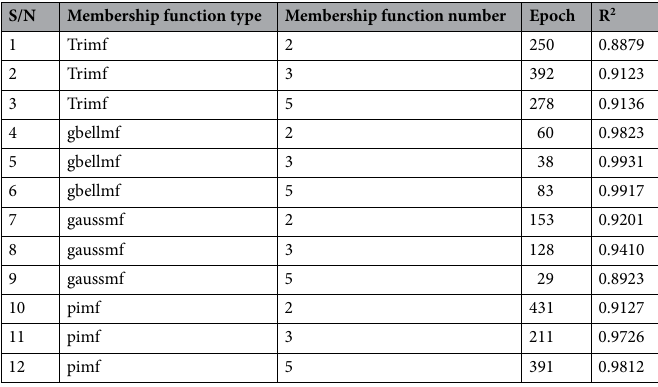
Table 4. ANFIS varied structural